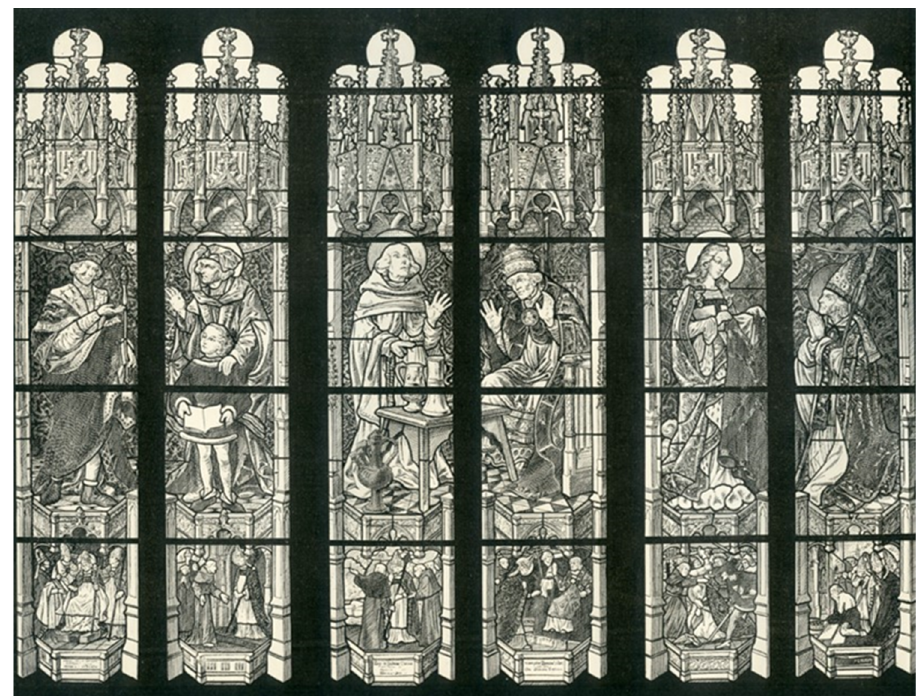
Figure 7. Saint-Lô, Church of Notre-Dame, Saint-Thomas chapel, print reproduction of the Life of Saint Thomas window, 1898, Félix Gaudin, glazier, window destroyed 1944. © unknown (image in the public domain).